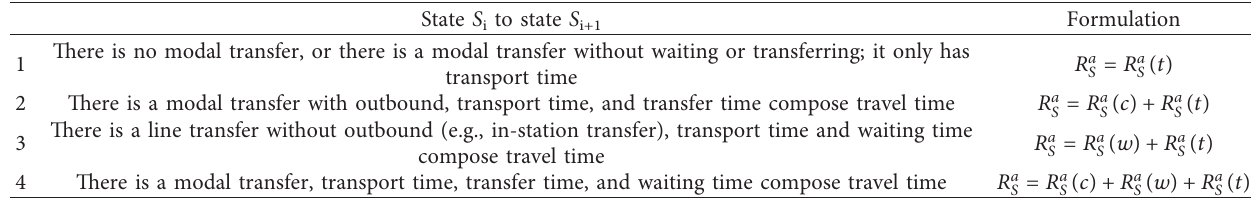
Table 1: Four types of travel time calculation formula in the multimodal trip